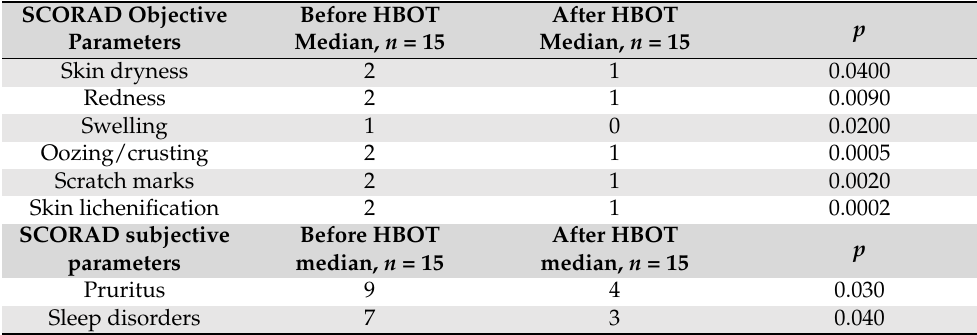
SCORAD subjective parameters